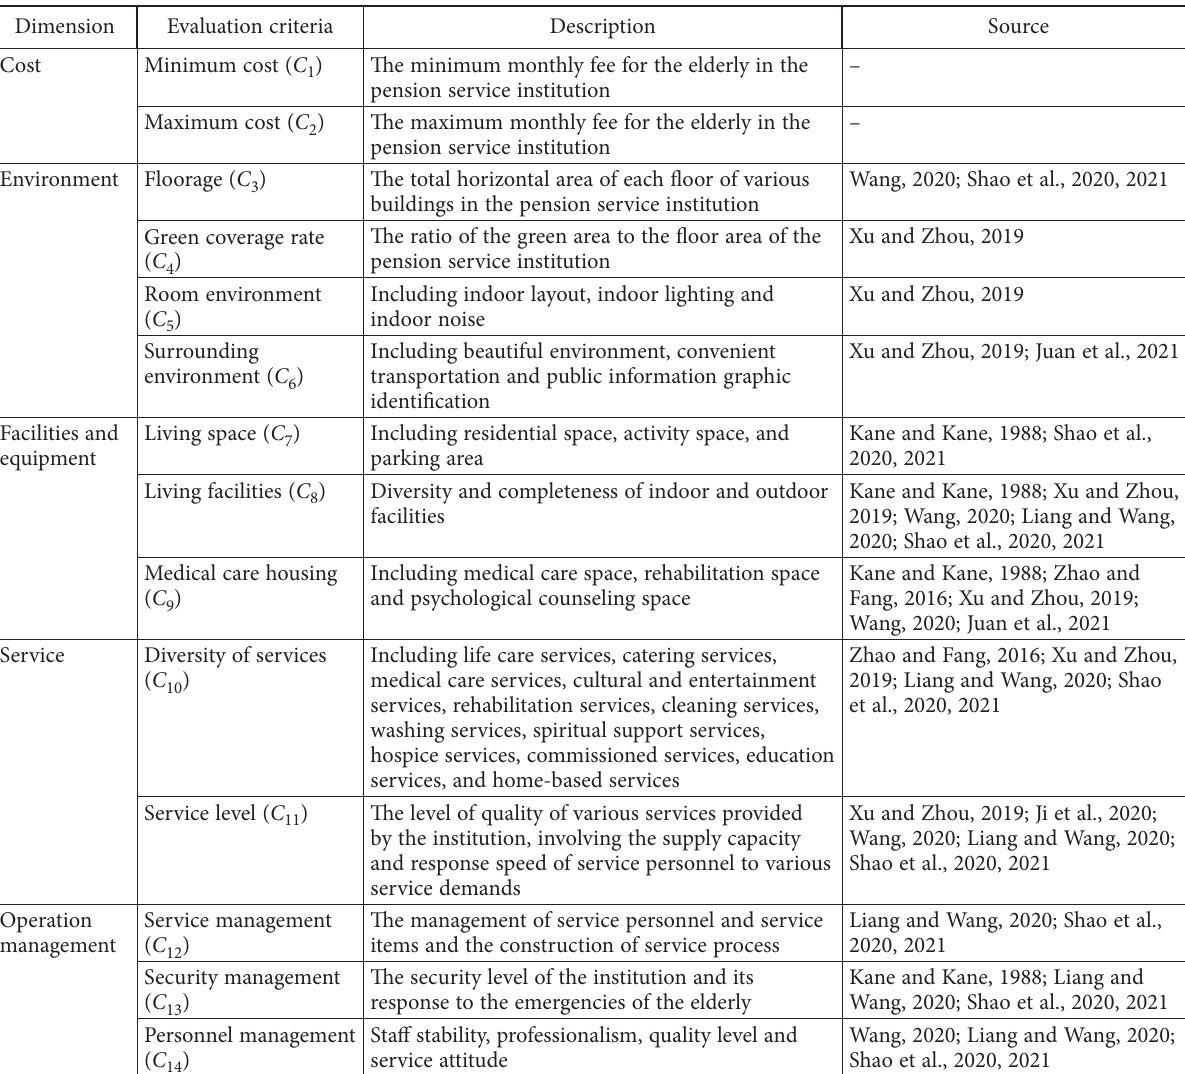
Table 1. The evaluation criteria for pension service